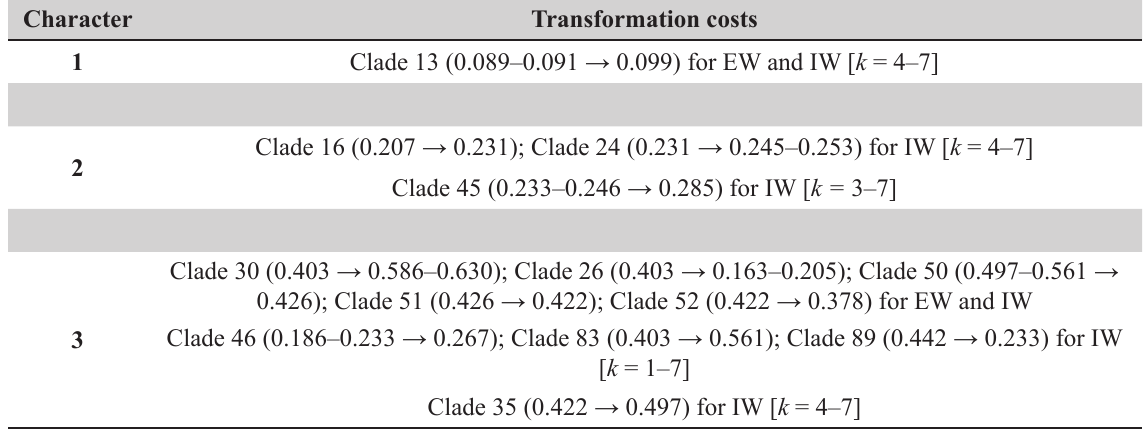
Table 8. Transformation costs for the continuous characters under equal and implied weights. Abbreviations: k = concavity constant; EW = equal weights; IW = implied